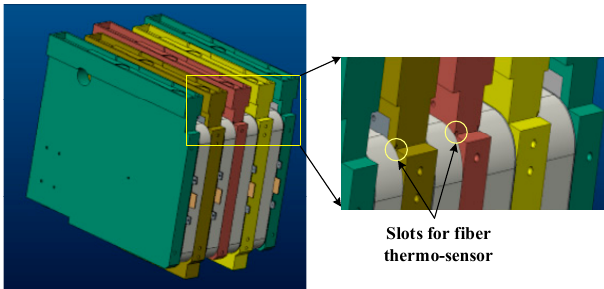
Figure 17. Positions of slots to place fiber thermos-sensors.